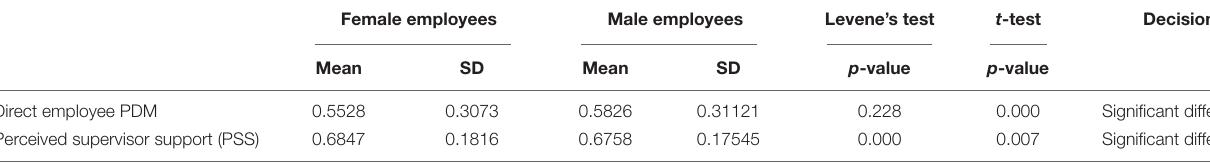
TABLE 2 | Descriptive statistics and hypothesis testing according to the gender of employees.